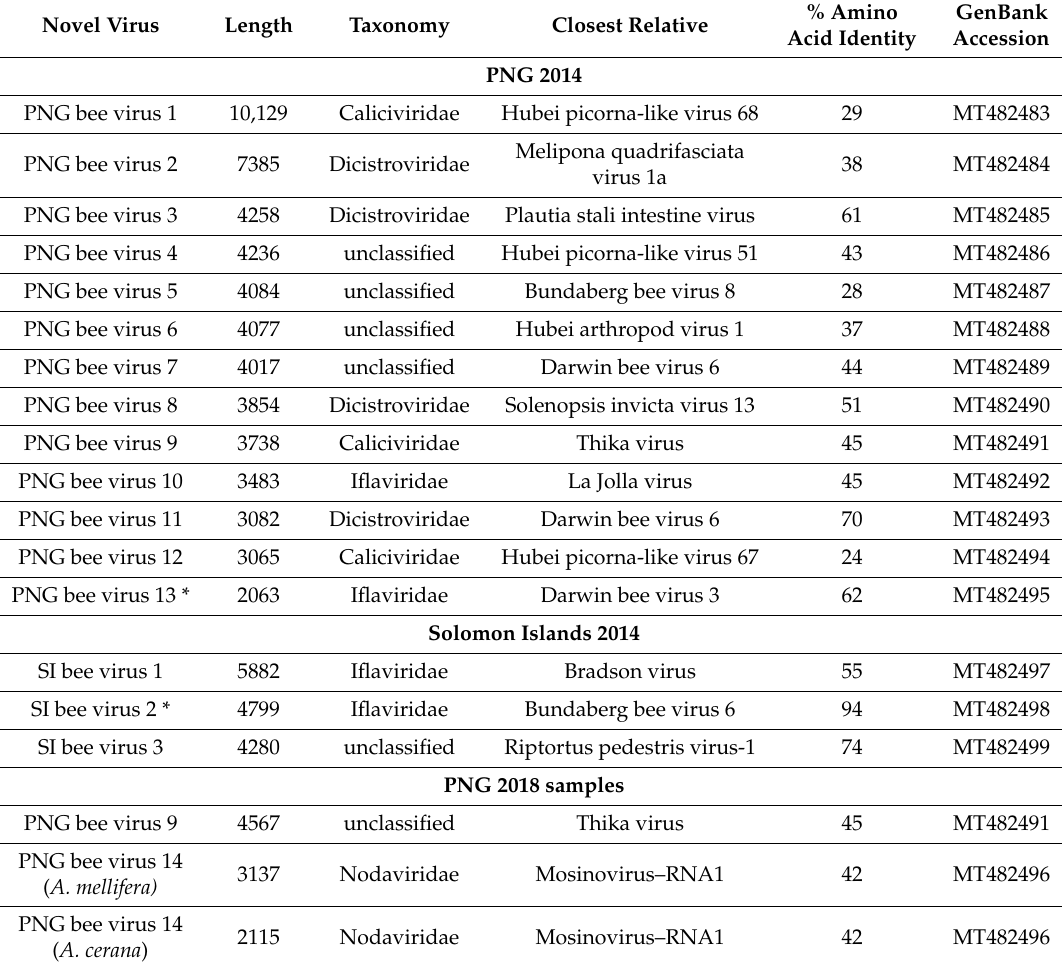
Table 2. Novel virus genomes detected in honey bees from PNG and Solomon